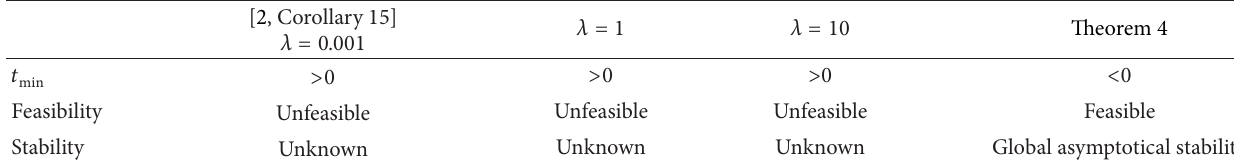
Table 1: Comparisons between [2, Corollary 15 ] and Theorem